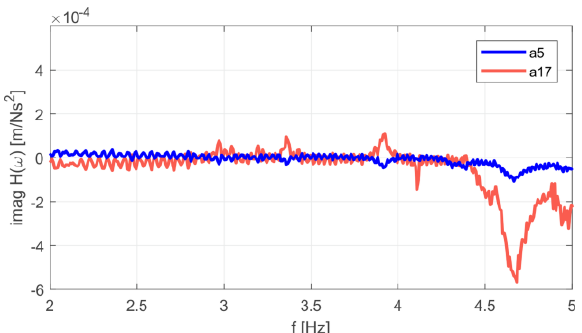
Figure 6. Imaginary parts of the frequency response function (FRF) for acceleration signals a5 (girder) and a17 (roof).